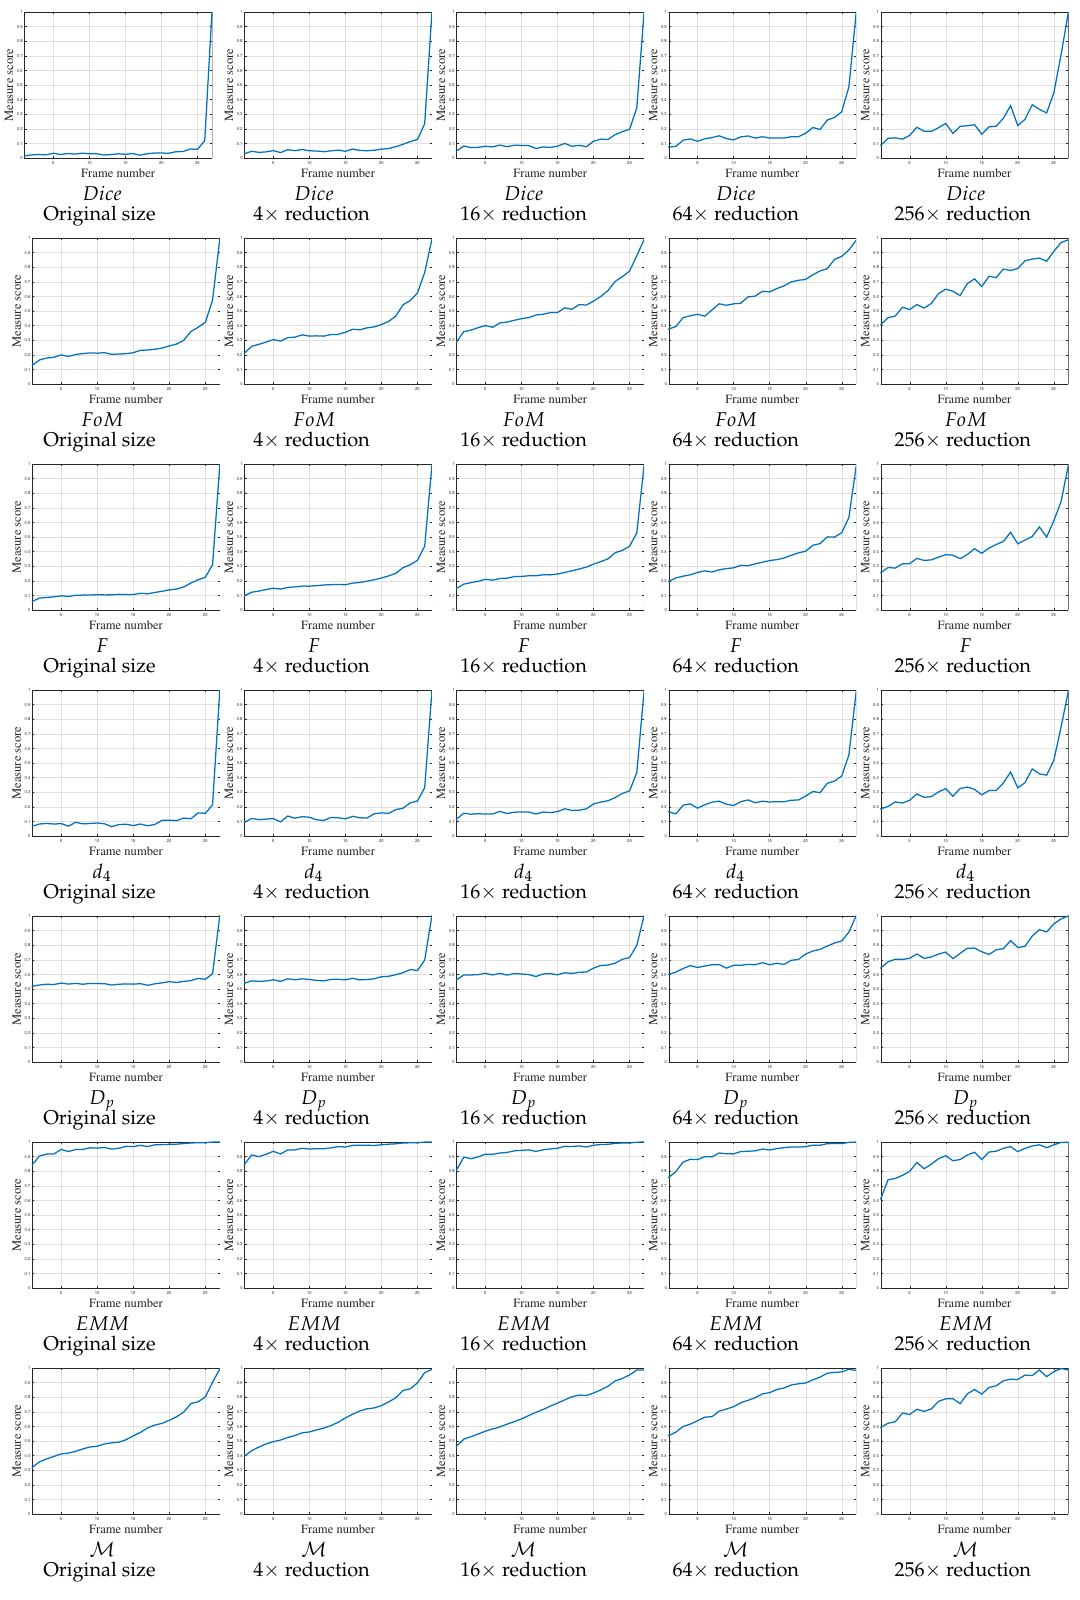
Figure 9. Localization metrics behaviors on real experiment concerning video 1 (V1) of 27 frames. The parameter concerning FoM , F , d 4 and D p is κ = 1/9. Concerning M , the parameters are µ FP = 1/ ∆ 2 and µ FN = 1/ ∆ , so µ FP < µ FN